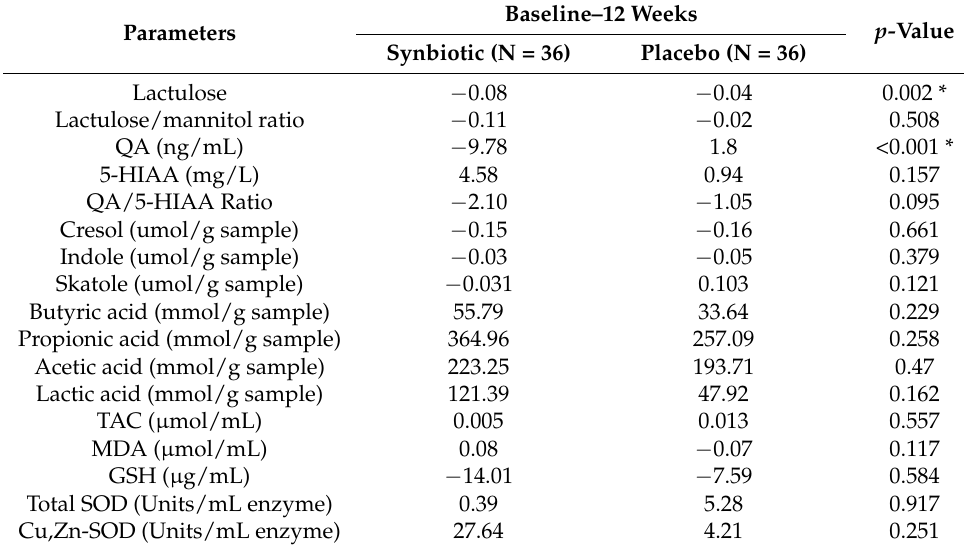
Table 5. Comparison of the changes in studied parameters between groups. Changes represent the difference between baseline and at the end of the